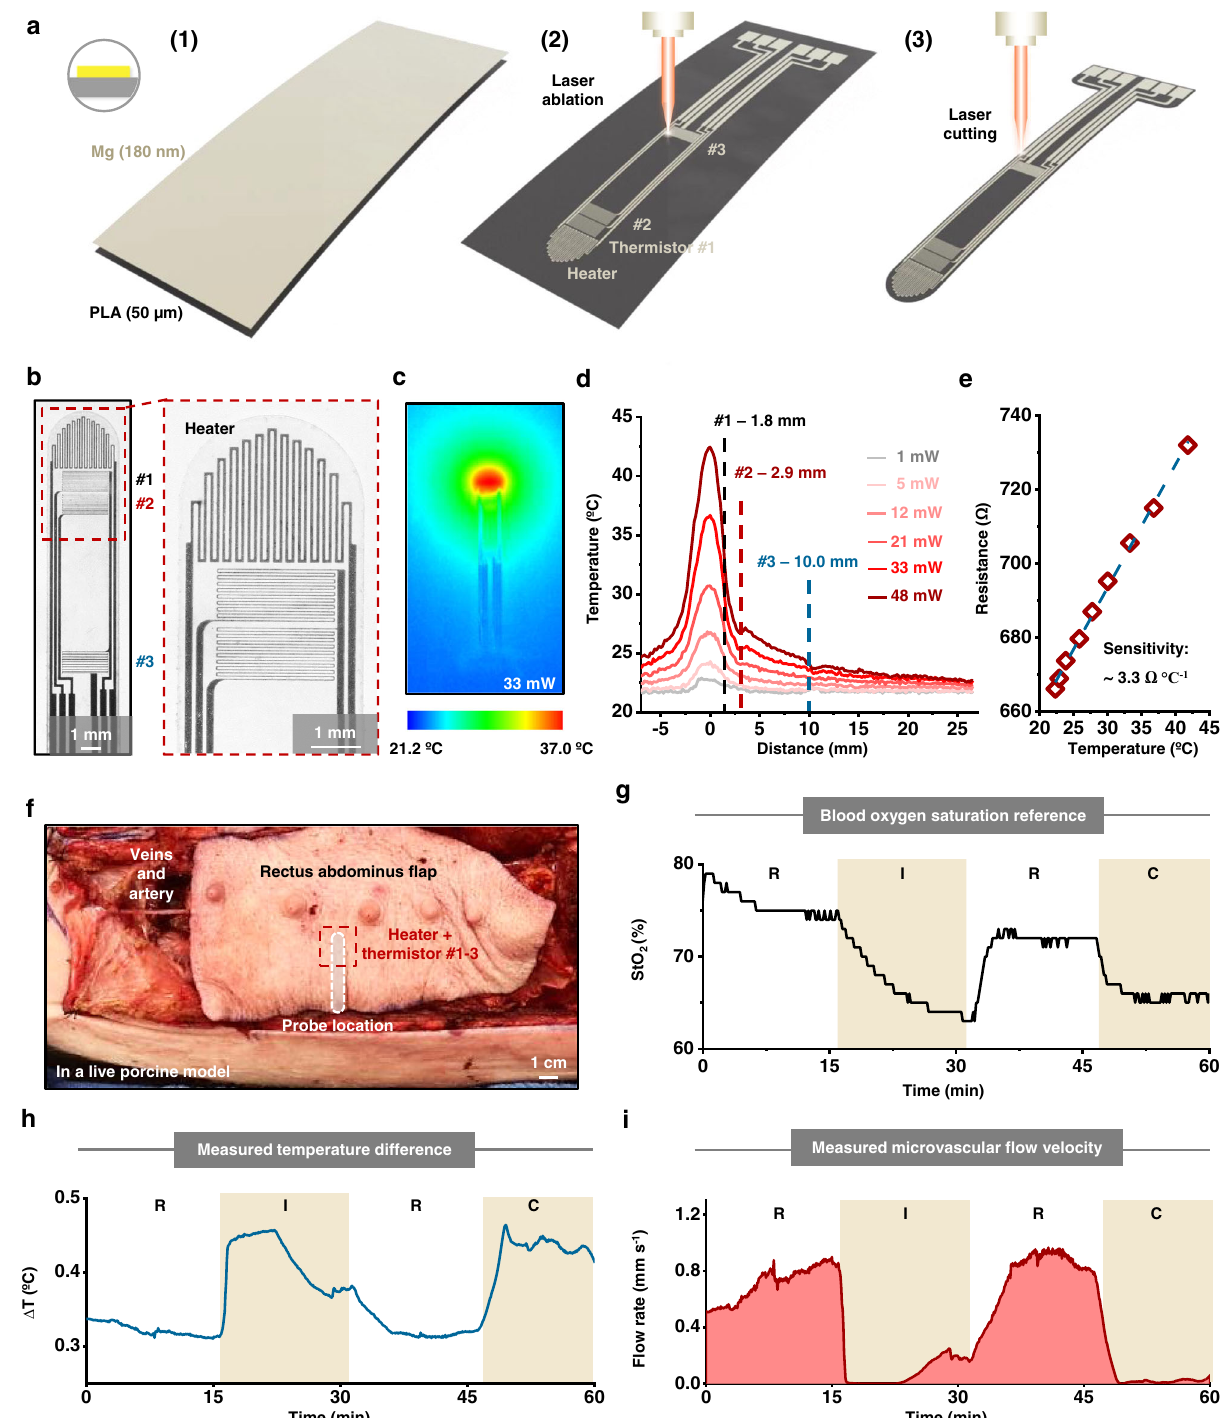
Fig. 4 | Process for fabricating bioresorbable microvascular fl ow sensing probes. Procedures. a Schematic illustration of the process, consisting of (1) vacuum deposition of a uniform Mg layer (thickness: 180nm) on a PLA substrate (thickness:50 µ m),(2)ablationoftheMglayertode fi nefourresistive-typedevices, (3) and ablation of the PLA substrate to de fi ne a narrow, needle-shaped geometry. b Optical micrograph of such a device, with a magni fi ed image in the inset to highlight the structures. c Temperature distribution around the probe. An input power of 33mW generates a maximum temperature increase of ~16°C in air. d Temperature distribution along with the fl ow probe at different heater powers. e Relationship between the resistance of the thermistor and temperature is linear overthisrange,withasensitivityof~3.3 Ω °C − 1 .Invivoacuteevaluationsinaporcine model using a rectus abdominus myocutaneous fl ap. f Optical image of the left